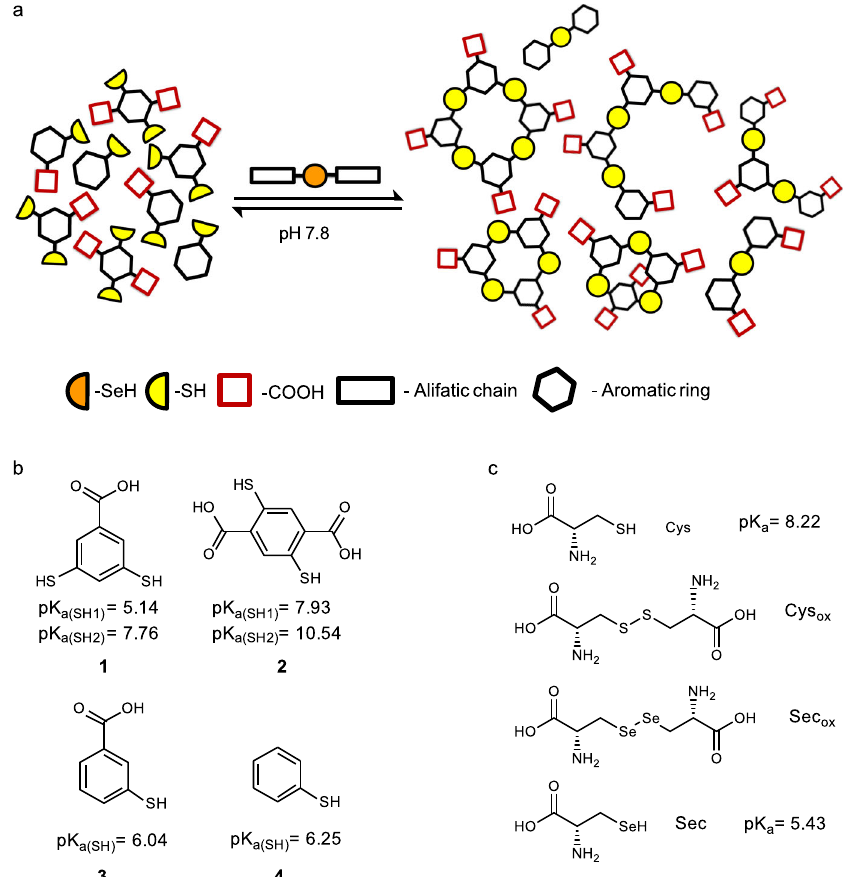
Fig. 3 Thiol/disul fi de catalyzed DCC. a DCC general scheme. b Building blocks of DCL. c Sulfur and selenium Cys and Sec derivatives. The p K a corresponds to the thiol group. Estimated p K a s data calculated with Epik as implemented in Schrödinger Suite Release 2020-2 54 – 56 and reported in the literature (Sec p K a 29 , Cys p K a 30 ). See Supplementary Fig. 1 for p K a